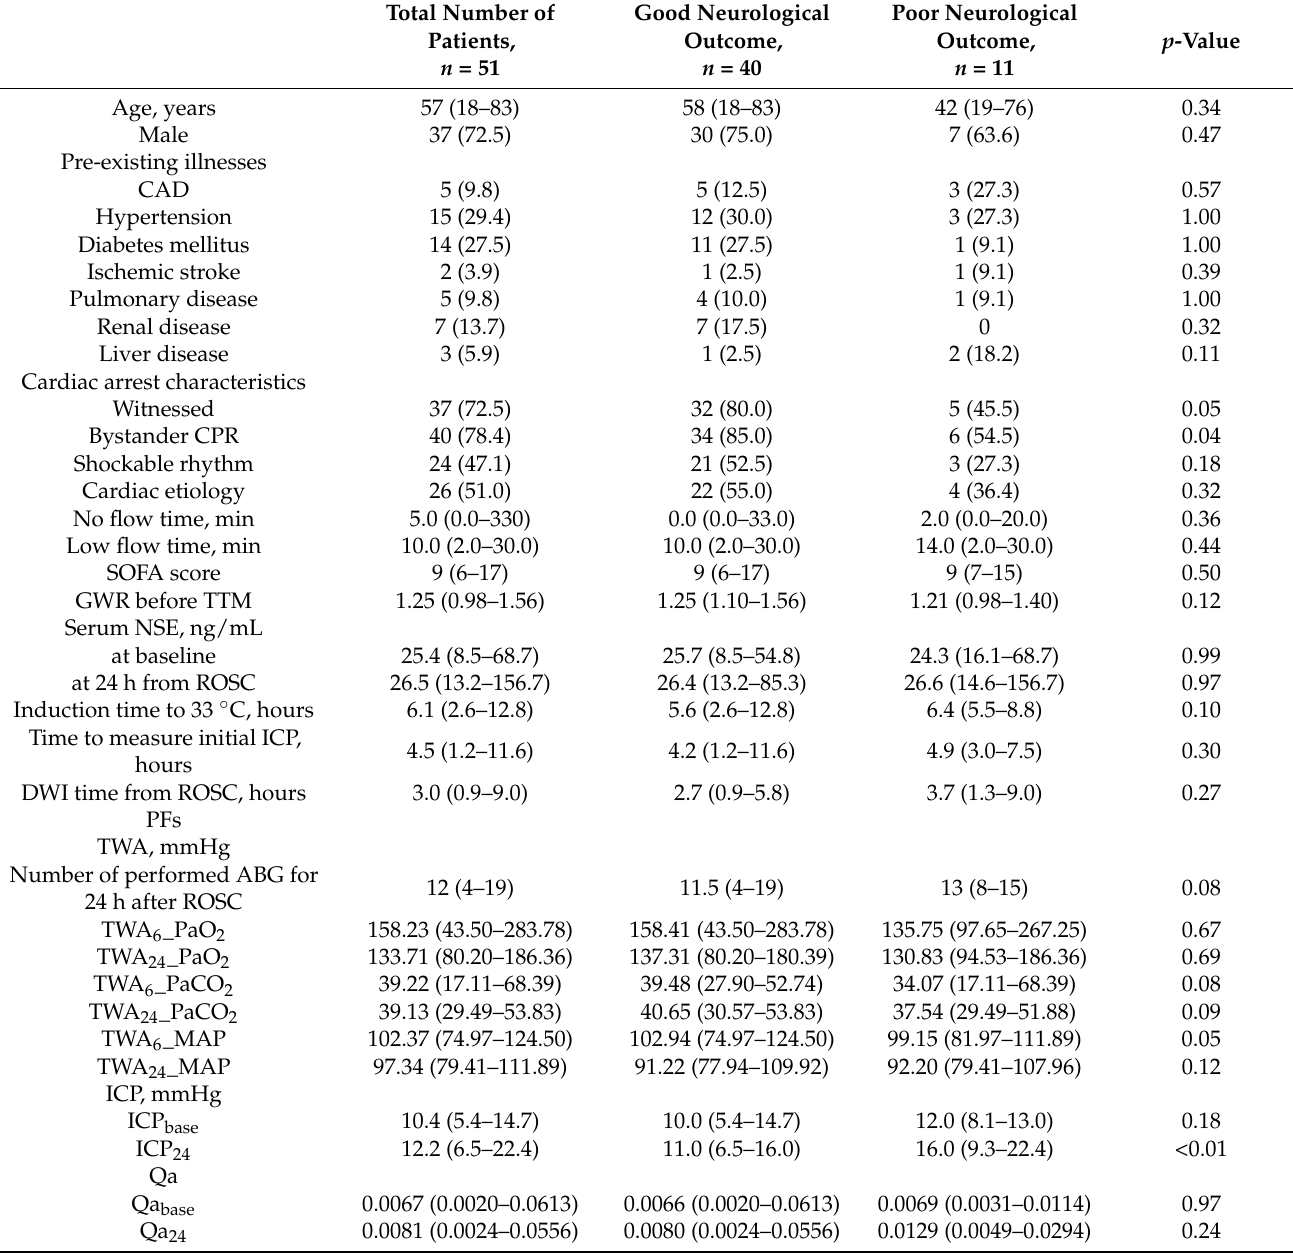
Table 2. Baseline demographics, characteristics, and PFs between good and poor neurological outcomes among patients without HSI on DWI performed before PCA